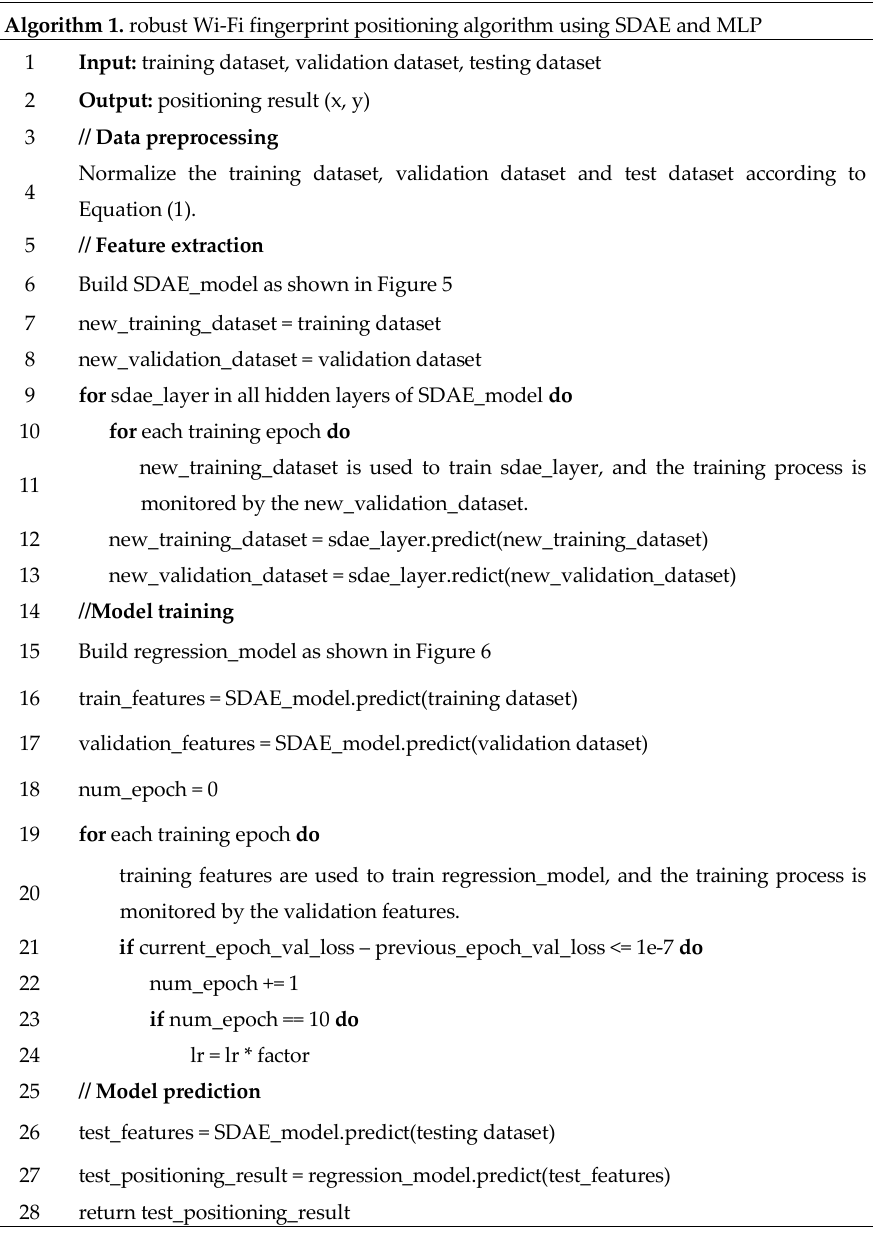
Figure 7. The pseudo code of the robust Wi-Fi fingerprint positioning algorithm using SDAE and MLP.